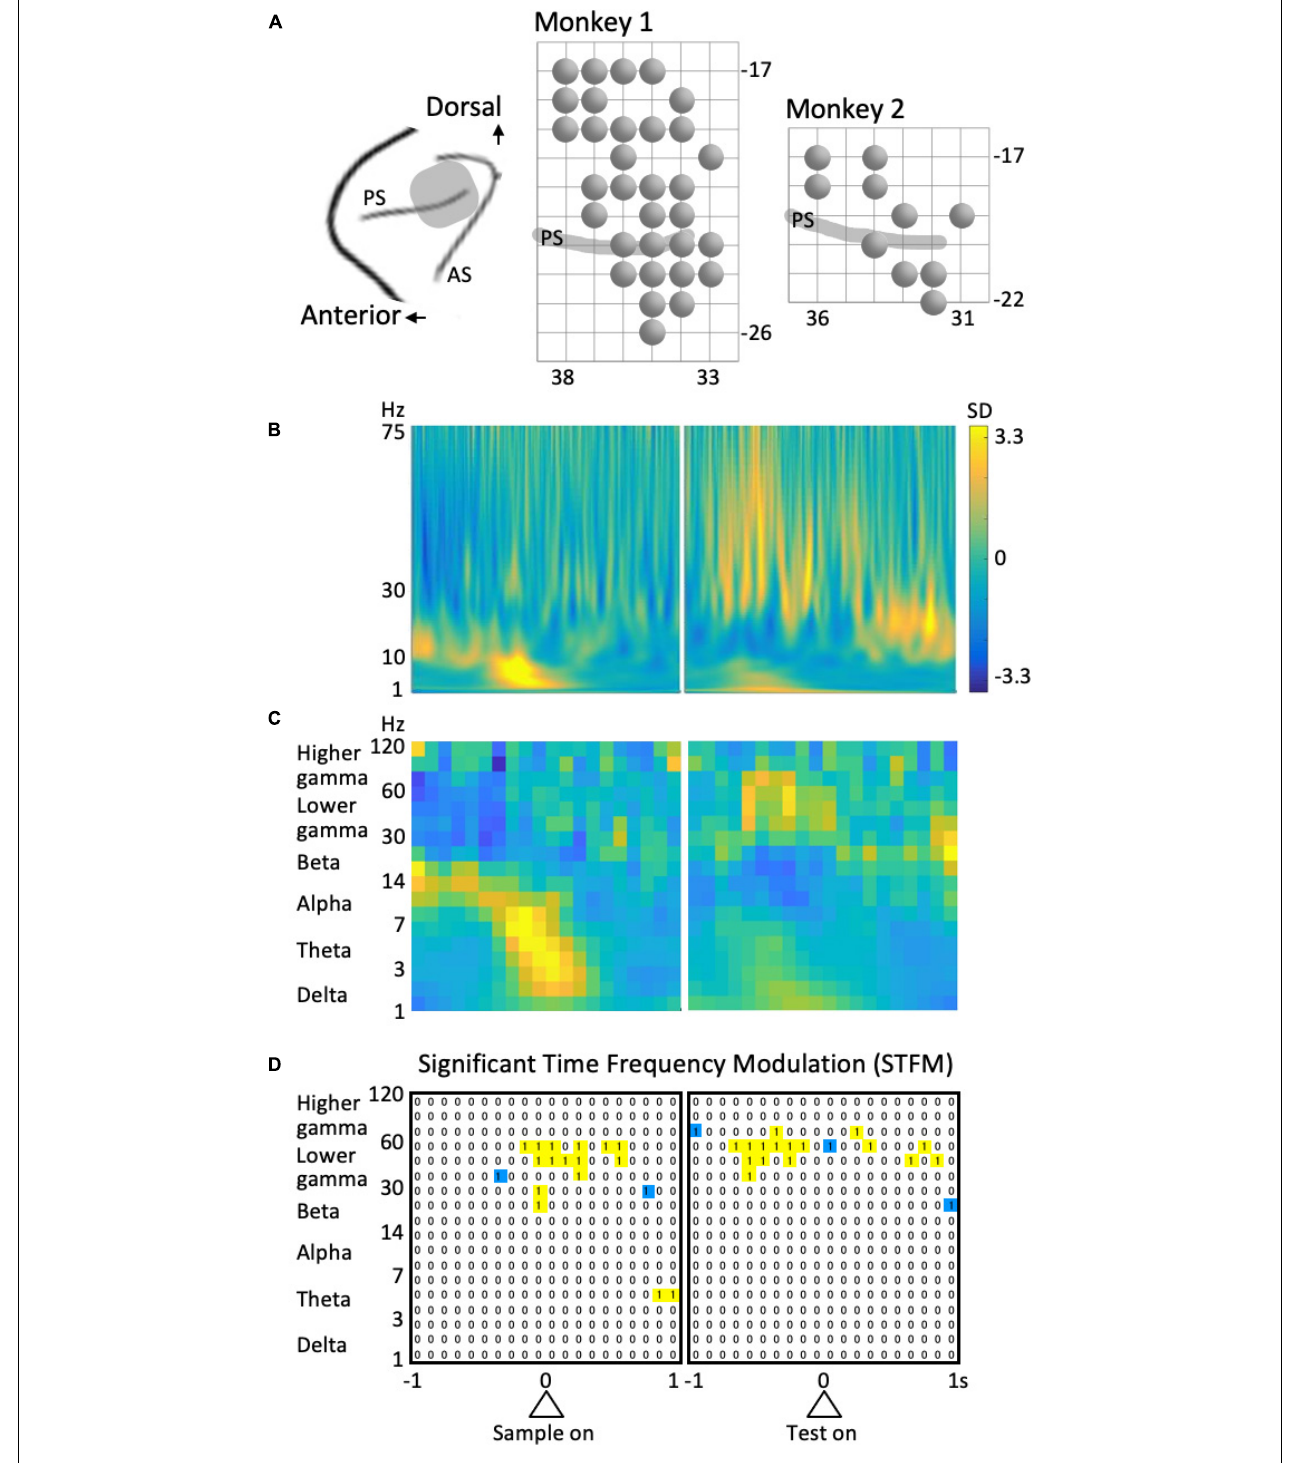
FIGURE 2 | Recording and analysis of LFPs. (A) Recording sites. PS, principal sulcus; AS, arcuate sulcus. A circle represents a recording site. The grid interval is 1 mm. (B) Example of the time-frequency spectrum averaged across all trials. Same site as in Figure 3 (left column). (C) The coarse-grained time-frequency spectrum obtained from (B) . (D) An example of the results of stepwise regression analysis for the data shown in Figure 4 (left column). “1” Represent the time-frequency region that provided a significant model including the predictor variable of interest. To avoid multi-comparison problems, isolated regions (blue) were